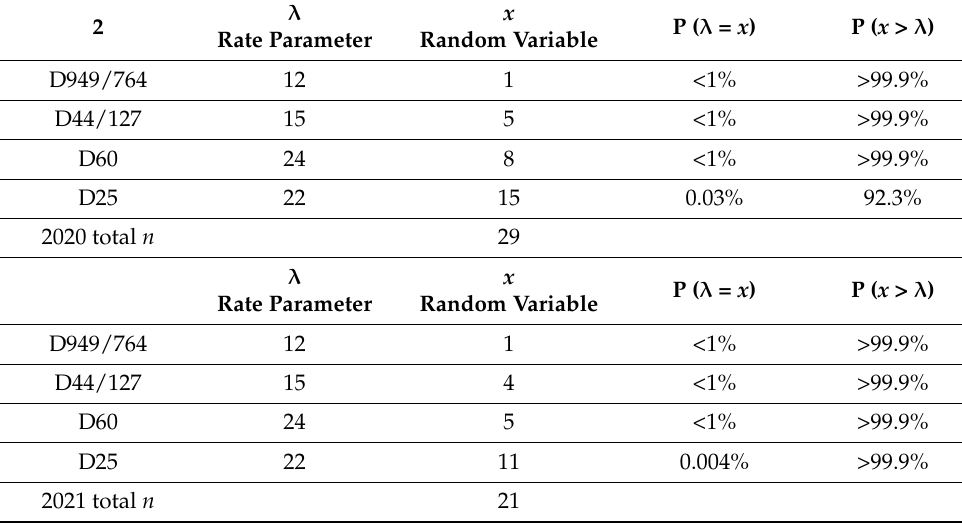
Table 3. Poisson probabilities that road mortality counts during 2020 and 2021 are a true measure of expected mortalities P ( λ = x ). The rate parameters ( λ ) are derived from the mean values of the long-term annual counts (15 years) and the random variable x from the observed numbers in each area during 2020 and 2021. The likelihood that the true counts were greater than the rate parameters ( x > λ ) ranged from 84–100% during 2020 and greater than 99% for